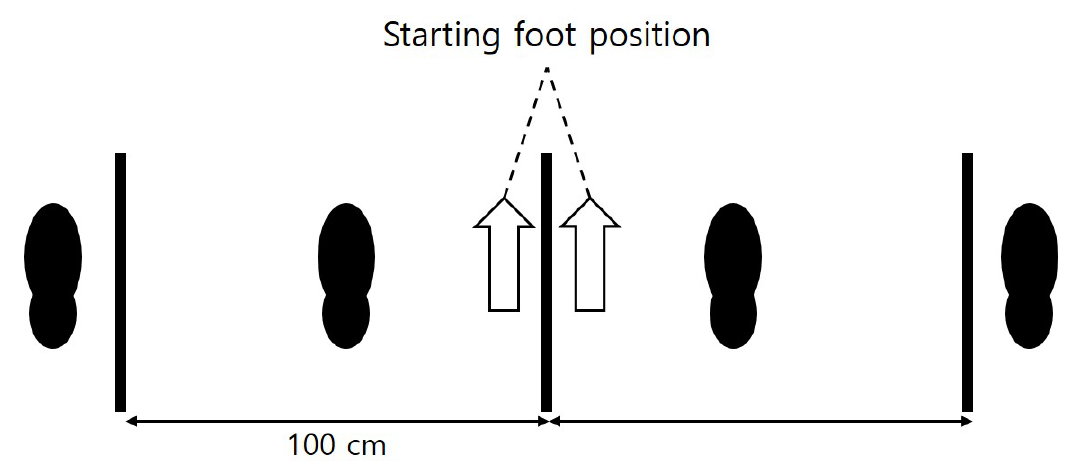
Fig. 2. Schematic representation of lines and tick marks for the side step test.